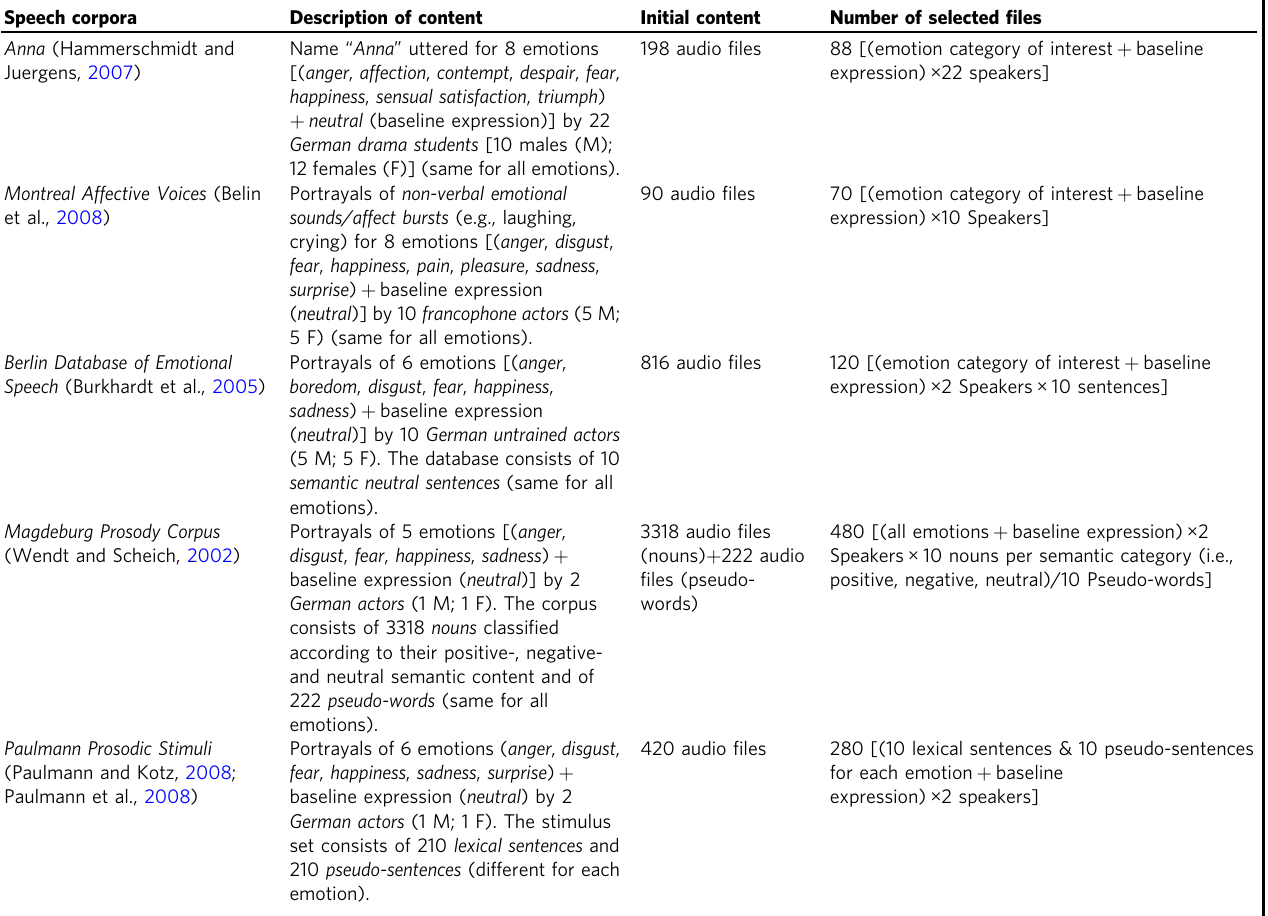
Table 1 Summary of the speech and non-speech datasets. Speech